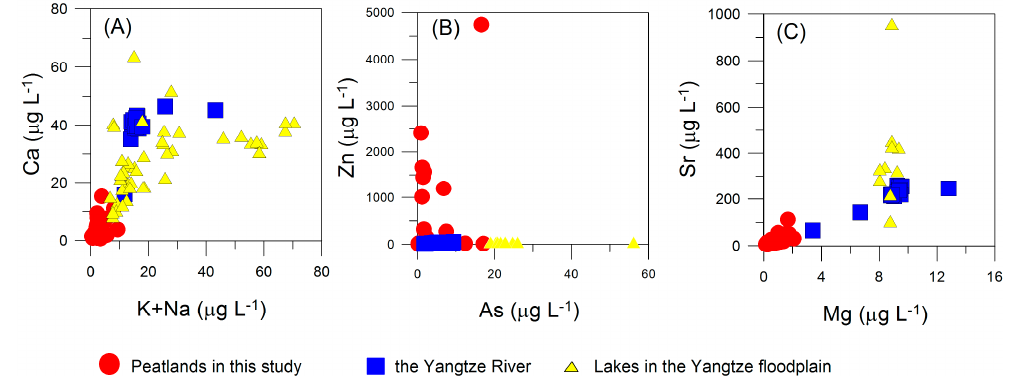
Figure 2. Diagrams showing the difference among peatlands, rivers, and lakes based on ( A ) Ca, K+Na; ( B ) Zn and As; and ( C ) Sr and Mg. Water chemistry data of rivers and lakes in the Yangtze basin are cited from the References of [29–31]. Table 1. Mean values and standard deviations of each environmental variable in different groups. Variables significantly different among the groups are marked based on a Kruskal-Wallis test.